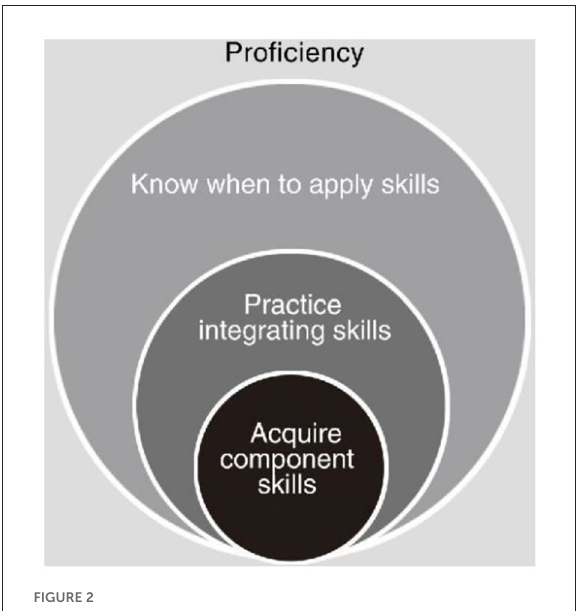
FIGURE2 The ingredients of